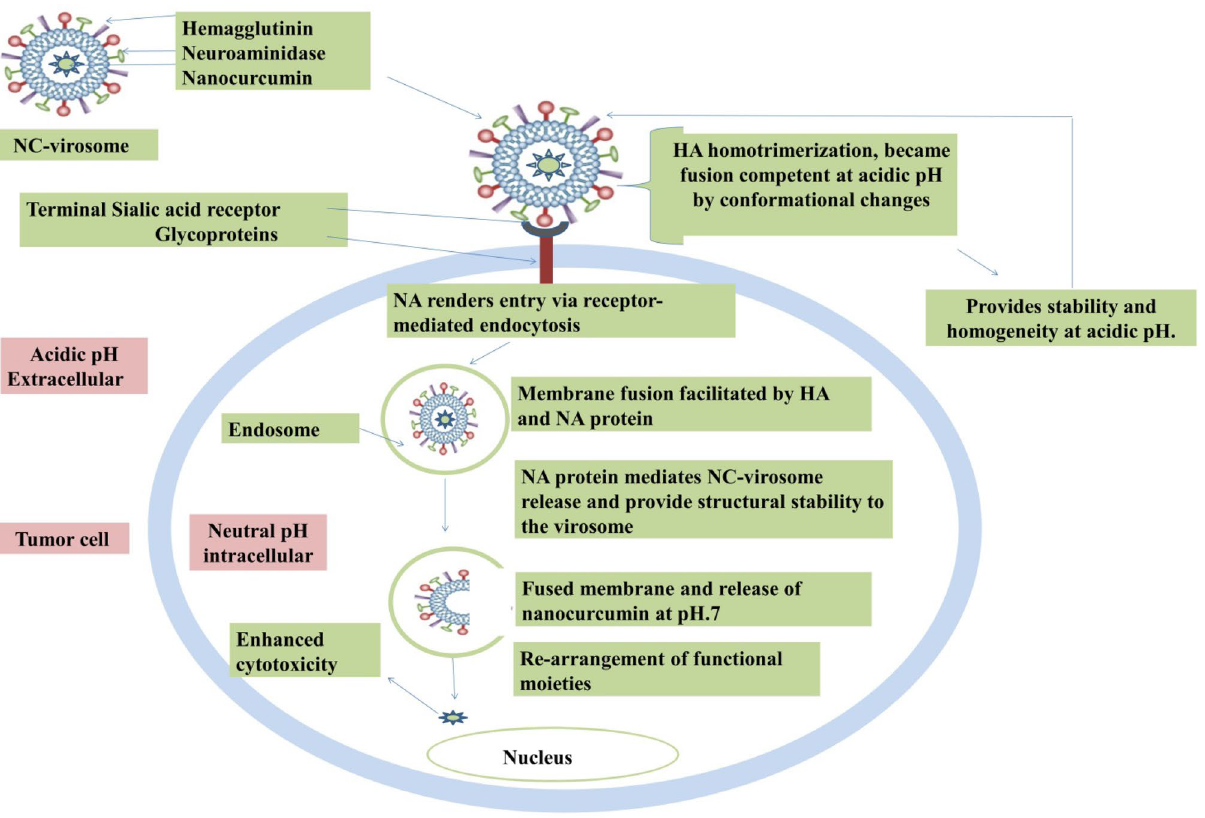
Figure 9. The mechanism of NC-virosome entry and nanocurcumin release inside the tumor